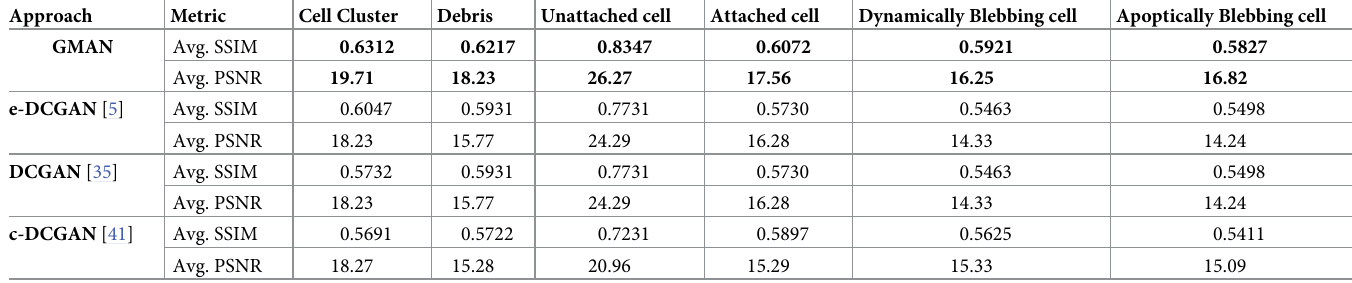
Table 12. Comparison of our GMAN architecture used in DeephESC 2.0 with e-DCGAN [5], DCGAN [35] and c-DCGAN [41] using the SSIM and PSNR metrics. SSIM has no units and PSNR is measured in decibels (dB).